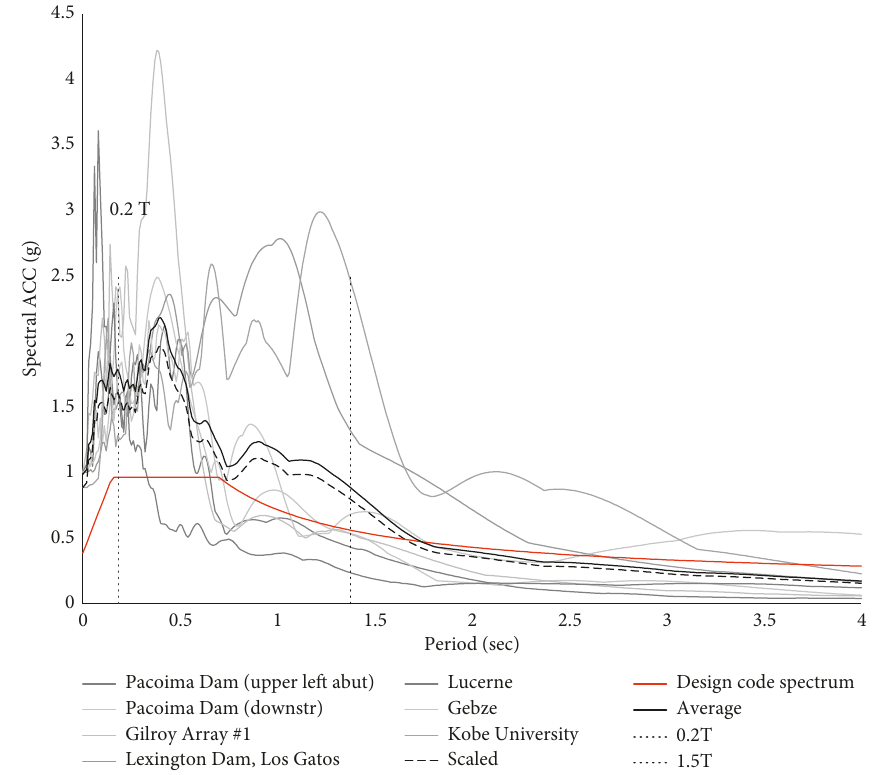
Figure 9: Elastic response spectral acceleration and scaling